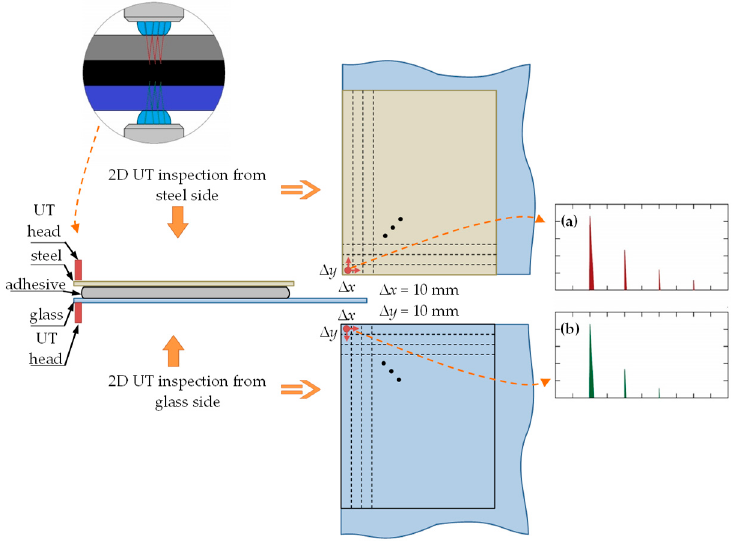
Figure 9. Diagram of ultrasonic testing system and visualization of the wave propagation in the tested sample: ( a ) the steel side testing, ( b ) the glass side testing.